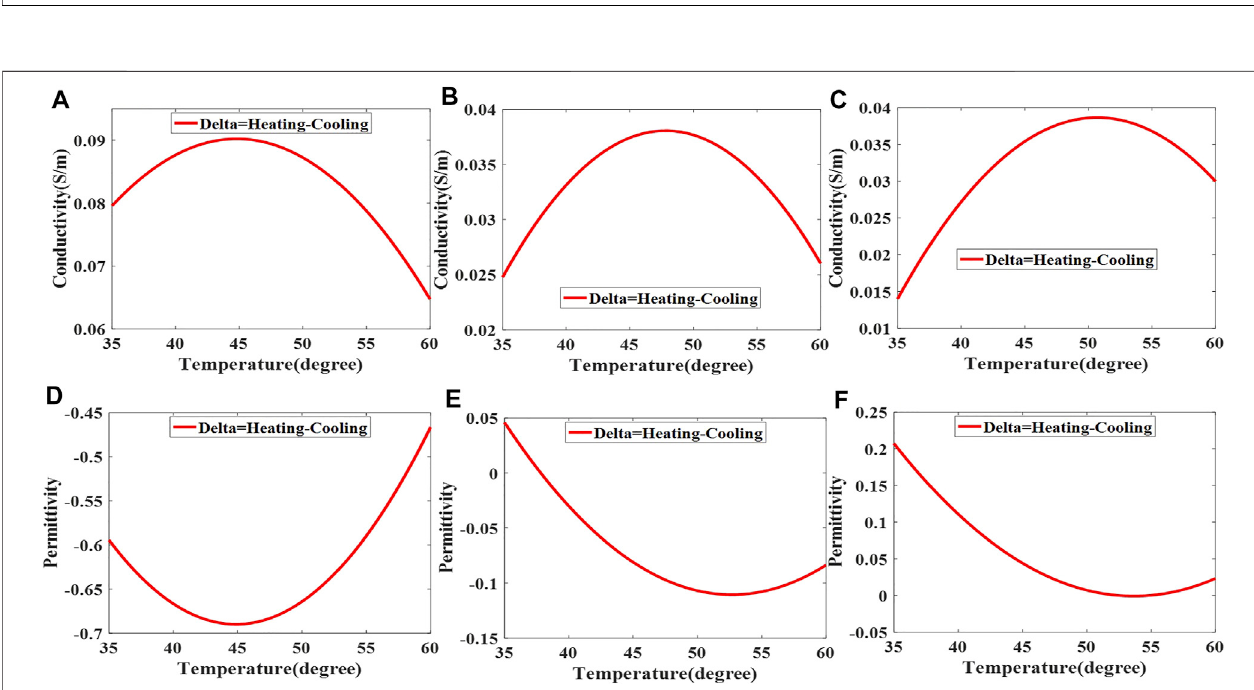
FIGURE8| Thedifferencebetweenconductivity (A – C) andpermittivity (D – F) oflivertissuesatthesametemperaturepointduringtheheatingandcoolingprocess.